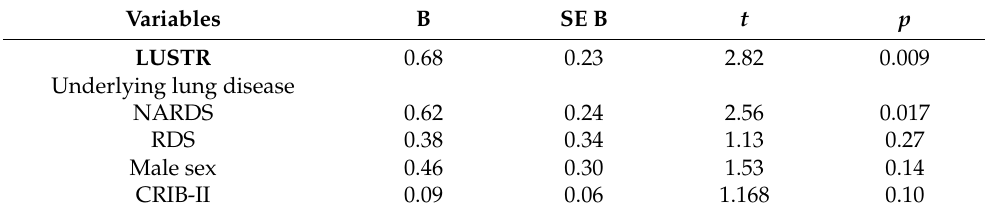
Table 3. Multiple linear regression for the log-transformed (delta) between the final and the initial oxygen saturation/fraction of inspired oxygen (SCR/F)